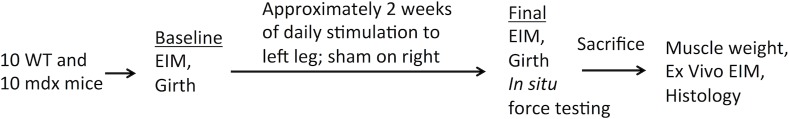
Schematic of study design.